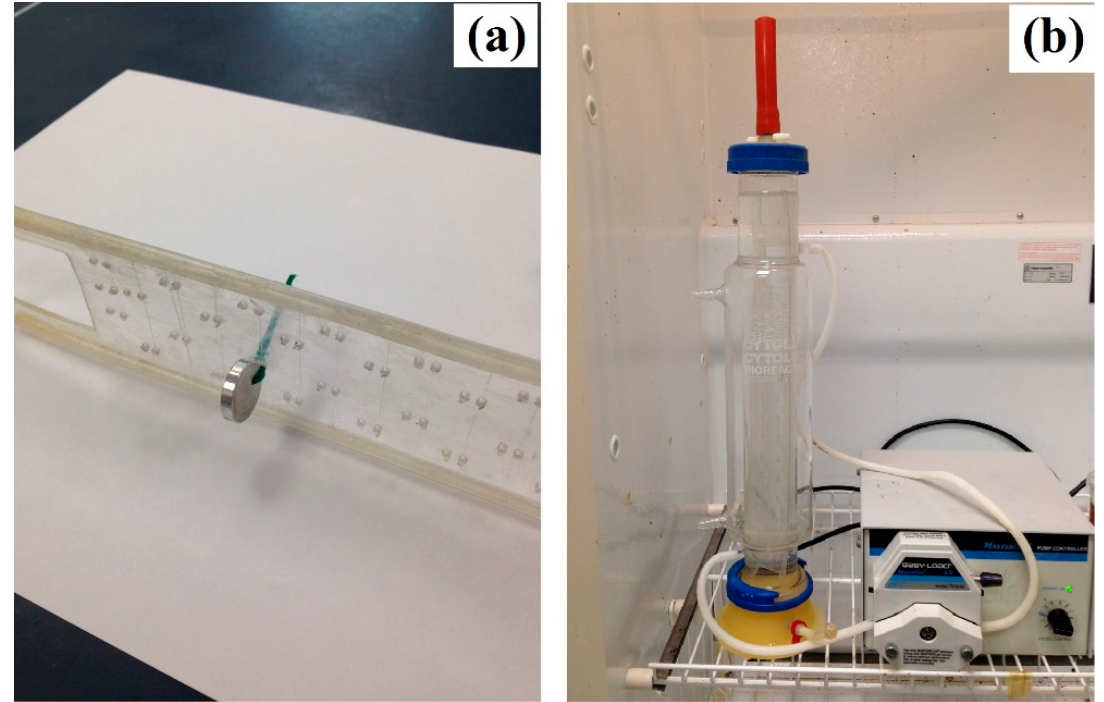
Figure 1. The setup for the glass reactor and the peristaltic pump. Table 1. Amounts of reagents for the preparation of 1000 mL solution of the simulated body fluid (SBF), adopted from Oyane et al. [29] .